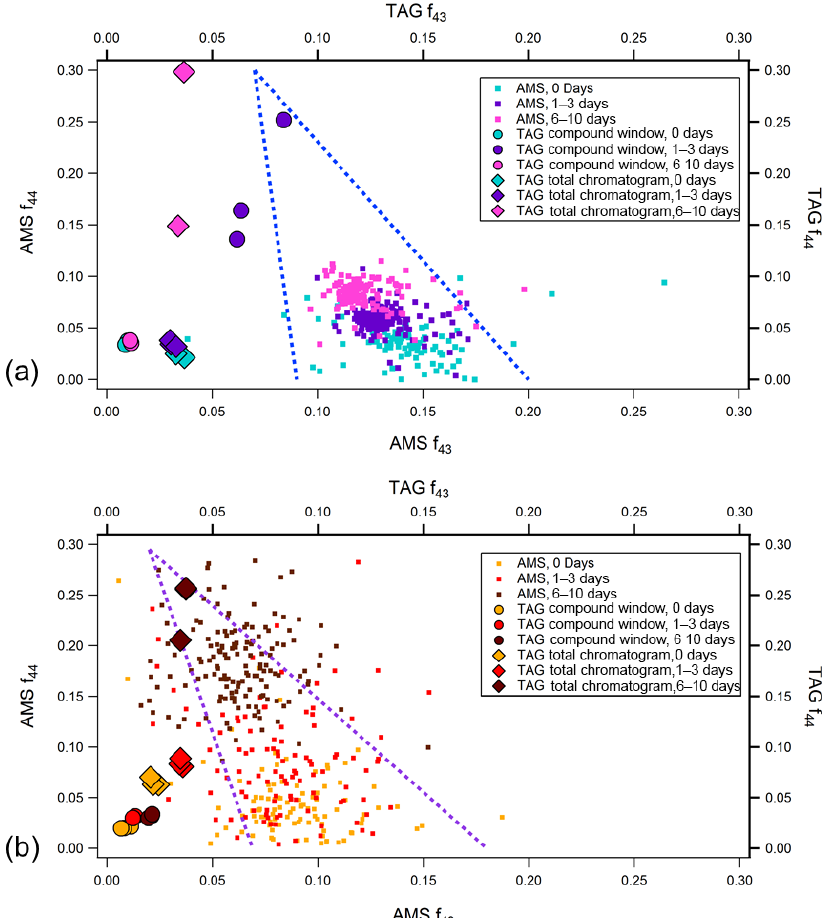
Figure 8. AMS and TAG f 44 vs. f 43 at different levels of photochemical aging for (a) leaf and (b) heartwood BBOA. TAG f 44 and f 43 values were obtained using Eq. (3). To minimize noise, AMS data are plotted only for points where sufficient total organic concentrations were achieved, around the peak of the concentration profile. The triangles formed by the blue dotted lines provide visual guidelines for the evolution of OA chemical composition across f 44 vs. f 43 space; the apex of the triangle indicates the direction of OA photochemical oxidation (Ng et al.,